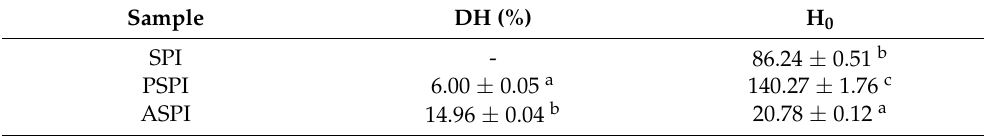
Table 1. Degree of hydrolysis (DH) and surface hydrophobicity (H 0 ) of SPI, PSPI, and ASPI.